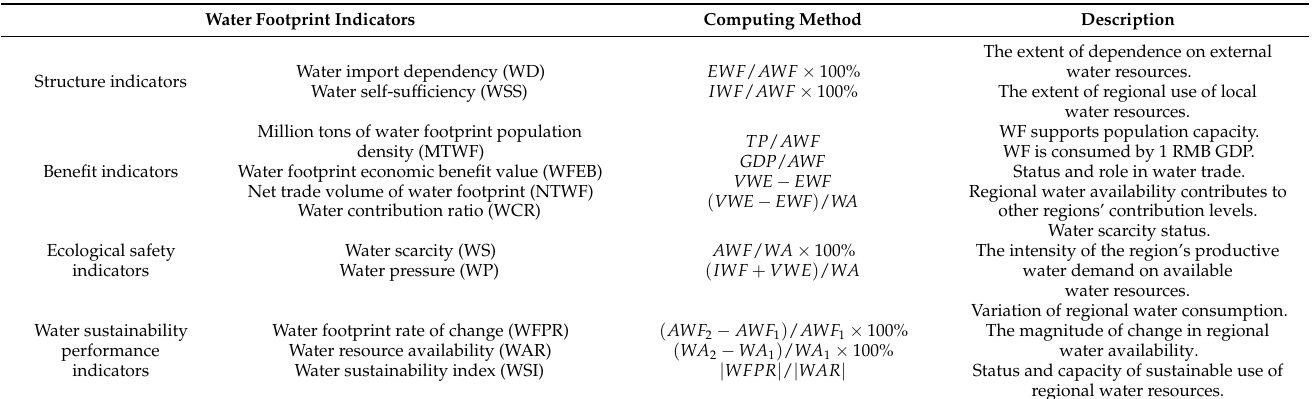
Table 1. Regional water resources evaluation index system based on WF.